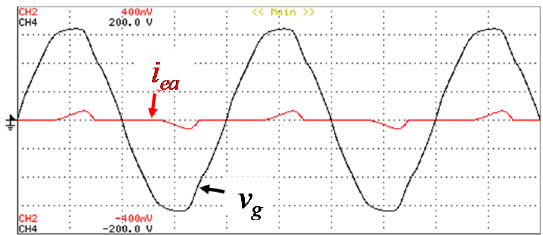
Figure 13. Experimental results without the operation of the MF-EVCS (in V2G mode): Ac-side voltage ( v g : 50 V/div); Electrical appliances current ( i ea : 10 A/div).